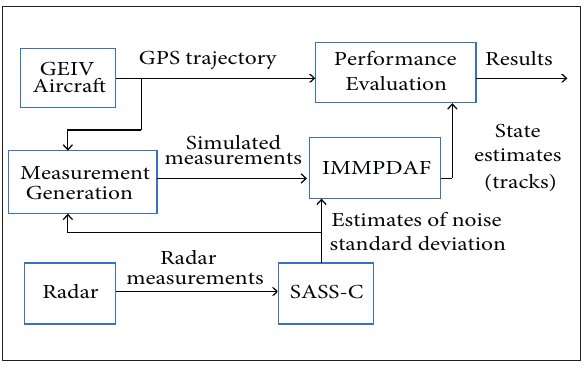
Figure 3. Performance evaluation with simulated